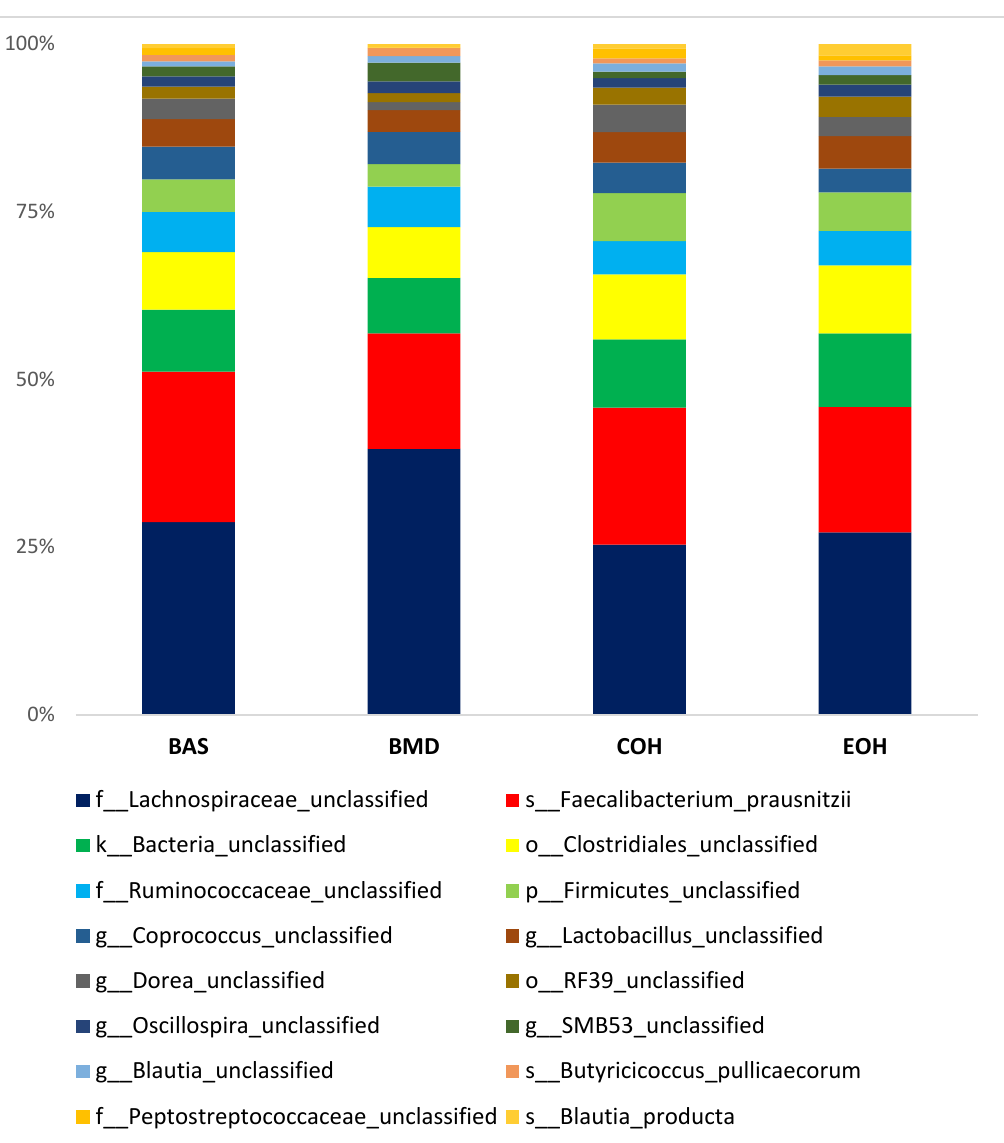
Figure 5. Illustration of the mean and standard error of the relative abundances of the most abundant species-level taxa within the four most abundant Phyla. The groupings along the y-axis represent the column of metadata. BAS = basal diet; BMD = antibiotic diet; COH = diet supplemented with 3% coarse oat hulls; and EOH = diet supplemented with 3% extruded oat hulls.